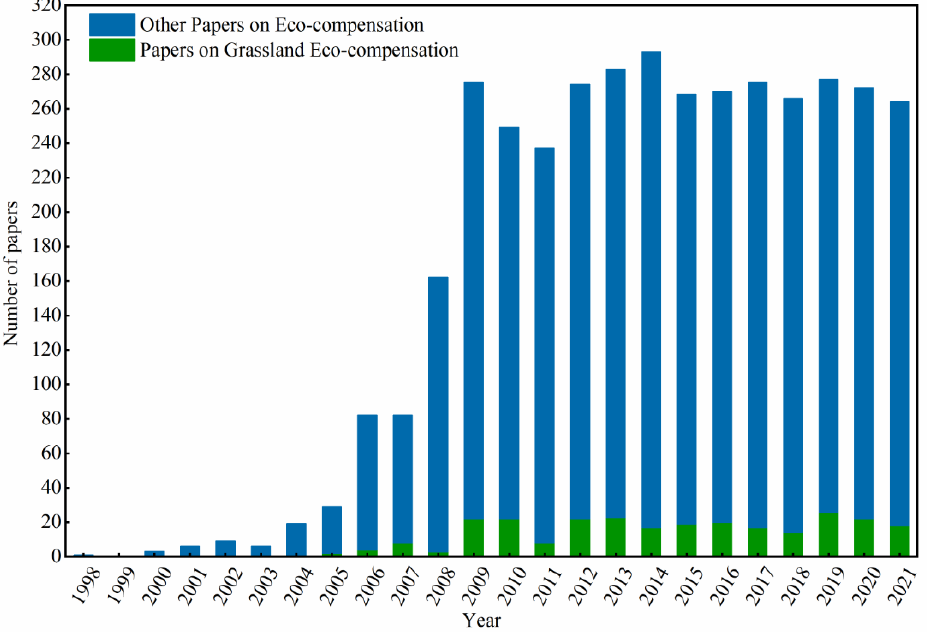
Figure 1. Overview of Eco-Compensation Research.